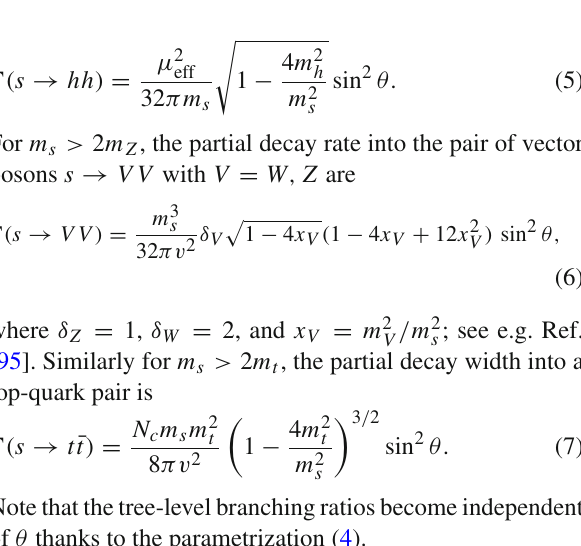
Fig. 2 Tree-level branching ratio for the decay of s in the μ eff vs. m s